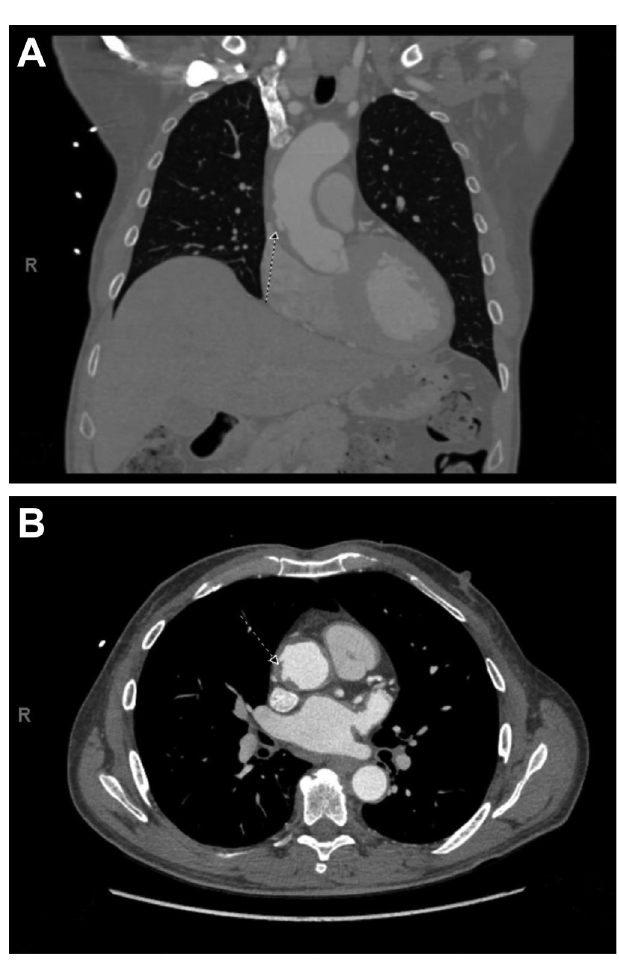
Fig. 1 - Computed tomographic angiograms in the A) coronal and B) axial views show intimal ulceration of the ascending aorta caused by a penetrating ulcer. Arrows indicate the